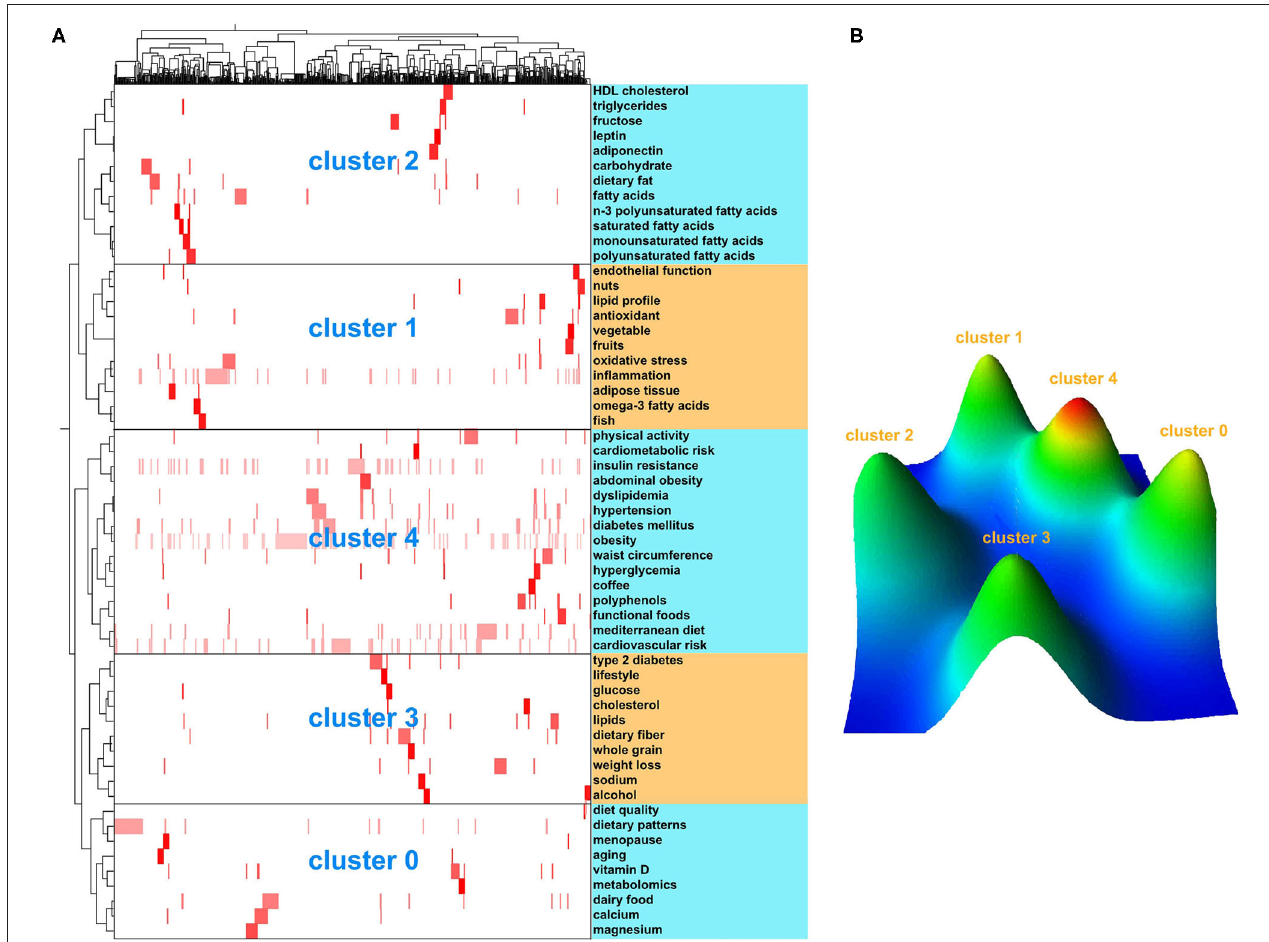
FIGURE 3 | The biclustering result of highly frequent keywords and source papers on dietary factors of MetS. (A) Matrix visualization of biclustering of highly frequent keywords and source papers on dietary factors of MetS; (B) Mountain visualization of biclustering of highly frequent keywords and source papers on dietary factors of